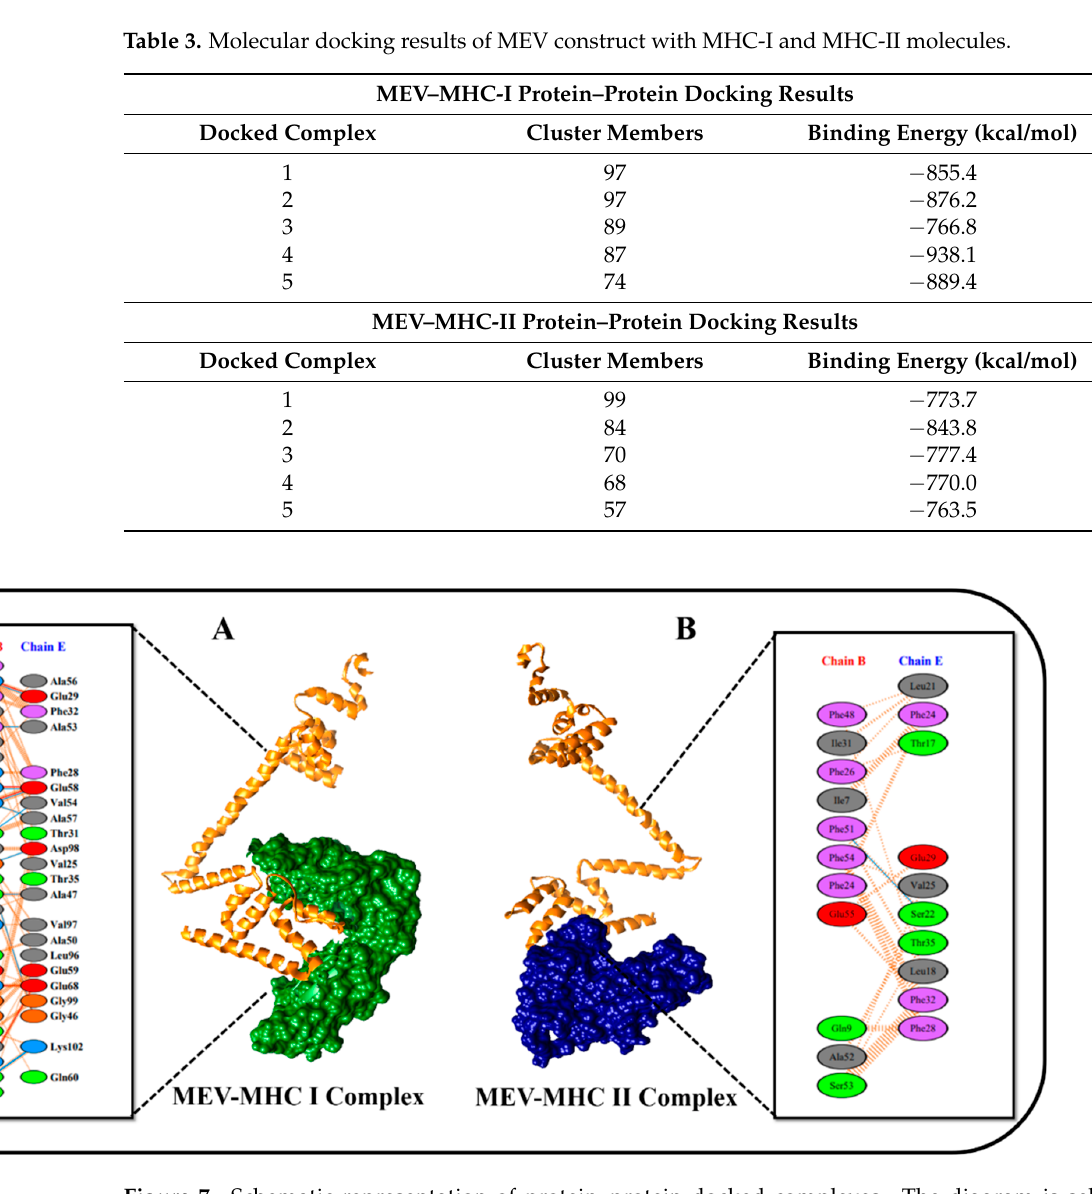
Figure 7. Schematic representation of protein–protein docked complexes. The diagram is self-ex- planatory; ( A ) protein–protein interaction diagram of MEV–MHC-I docked complex. Construct is shown in orange color, and MHC-I receptor is shown in green color. ( B ) Protein–protein interaction diagram of MEV–MHC-II docked complex. Construct is shown in orange color, and MHC-II recep- tor is shown in navy-blue color. is shown in navy-blue